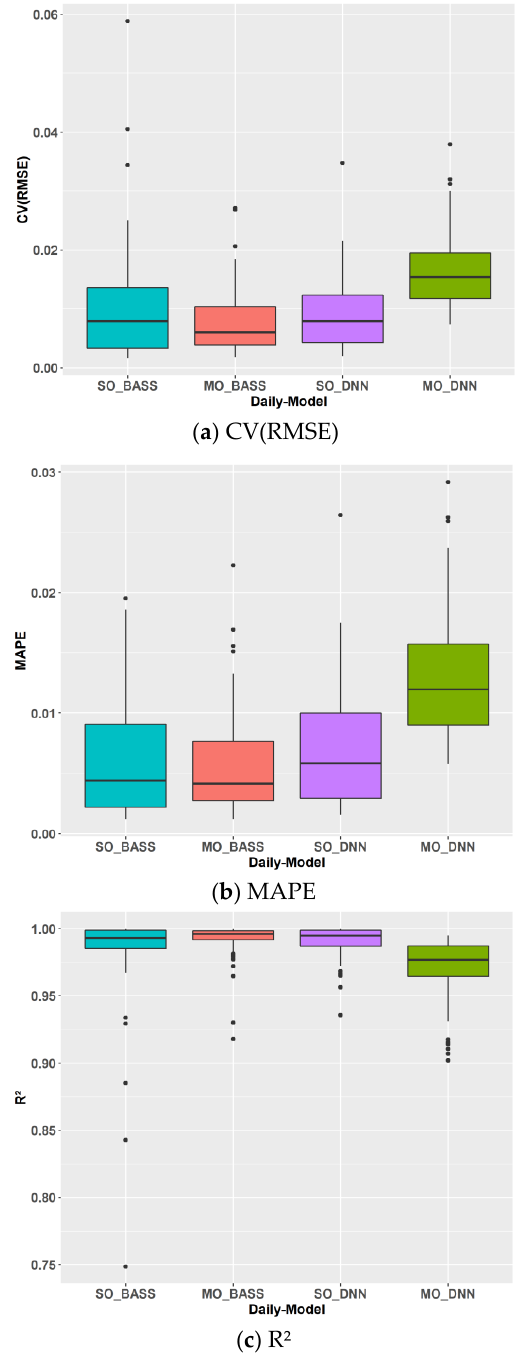
Figure 4. Prediction performance of machine learning models for daily cooling energy (SO, single output; MO, multiple output).